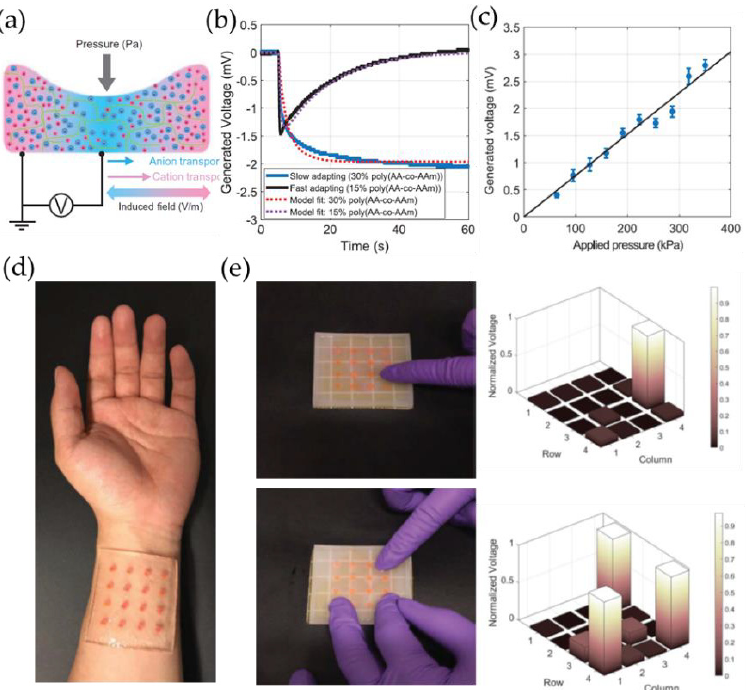
Figure 9. ( a ) The schematic illustrates a hydrogel undergoing indentation, with differential ionic displacement and field observed. The smaller red cations are transported through the green poly- mer chain network more rapidly than the blue anions, creating a charge imbalance and generat- ing an electric field. ( b ) Voltage response of PAAm hydrogel upon step compression at 20 kPa. ( c ) Peak voltage produced in relation to the pressure being applied. ( d ) A wrist-mounted 16-element piezoionic mechanoreceptor array. ( e ) Photograph and related normalized voltage bar plot of the piezoionic mechanoreceptor array that detects single and multiple touches. (Reprinted with permis- sion from